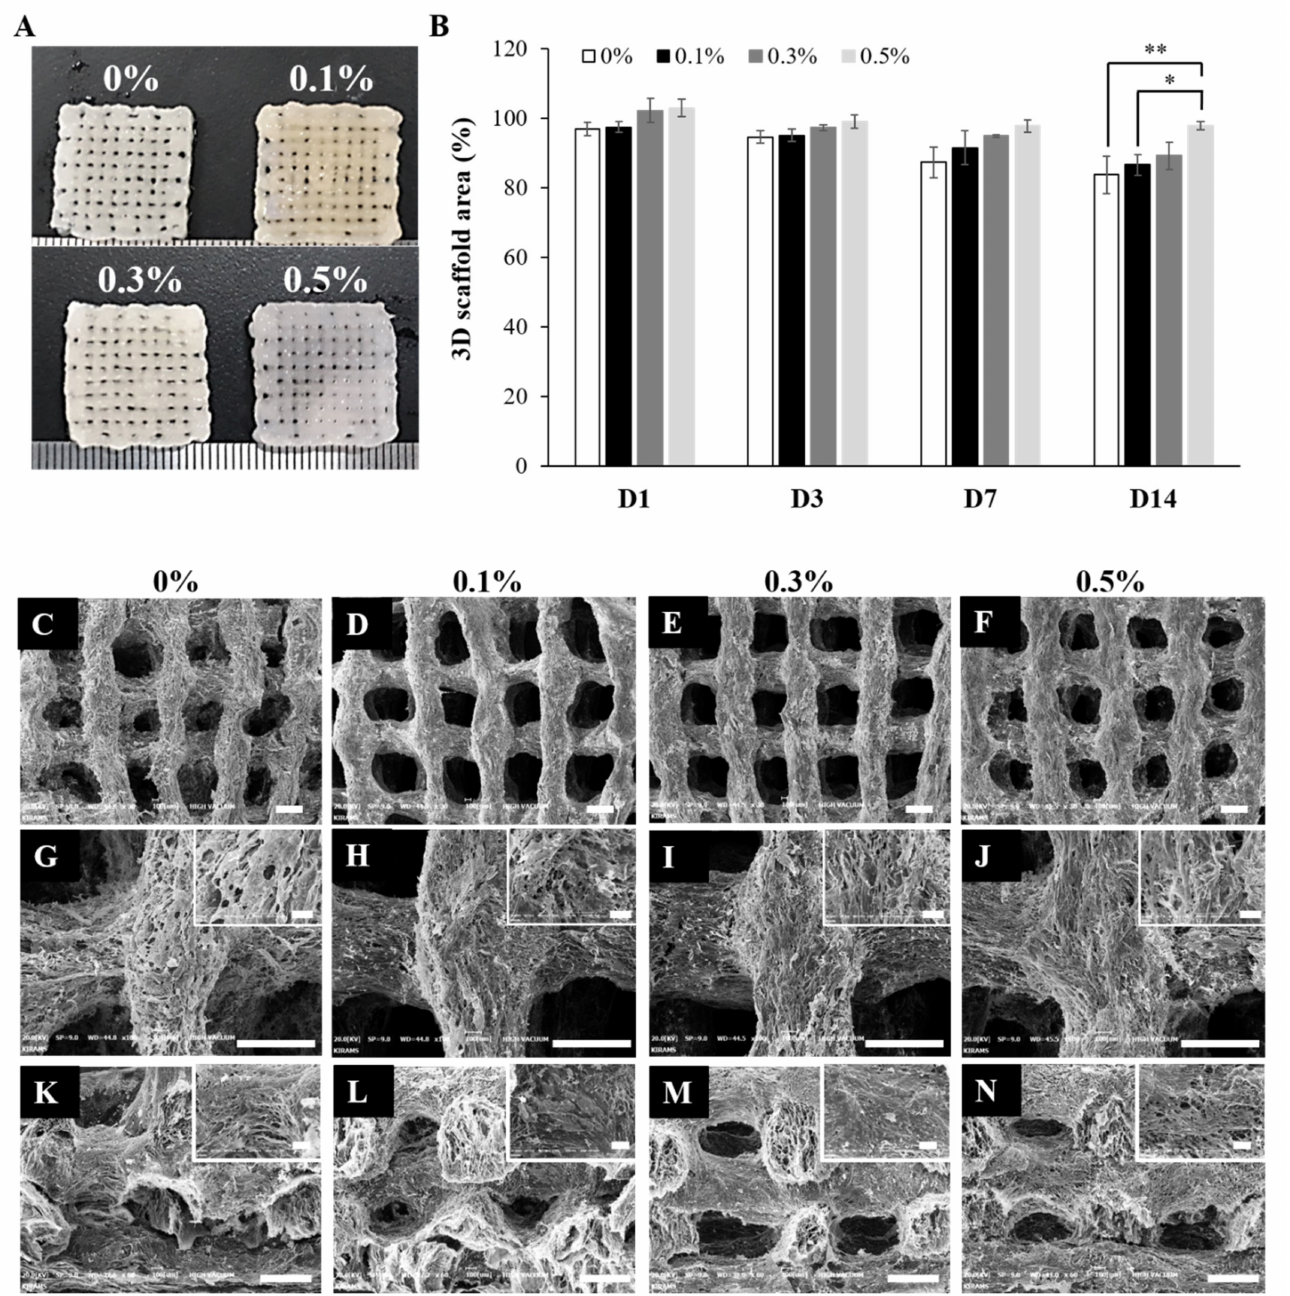
Figure 8. Effect of suture fiber content on 3D printed scaffold cell-mediated contraction. ( A ) Images of the cell cultured 3D scaffolds at 14 days of culture. ( B ) Cell cultured 3D scaffold areas (%) at different culture times ( n = 4) (* p < 0.05 and ** p < 0.01). ( C – N ) SEM images at 14 days of culture of the ( C – J ) surfaces and ( K – N ) cross sections of the cell cultured 3D scaffolds reinforced with suture fibers at contents of ( C , G , K ) 0%, ( D , H , L ) 0.1%, ( E , I , M ) 0.3%, and ( F , J , N ) 0.5%. (Scale bar: 500 µ m; inset scale bar: 100 µ